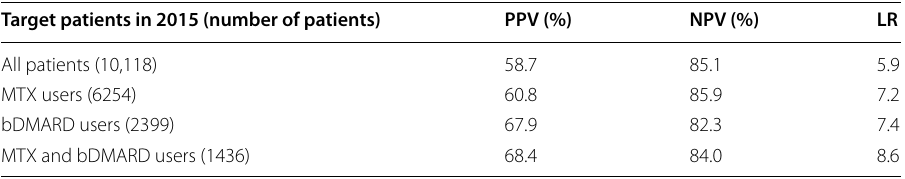
Transformation matrices were derived from the patients in 2013 and 2014 with concordant medication of target patients PPV positive predictive value, NPV negative predictive value, LR positive likelihood ratio methotrexate